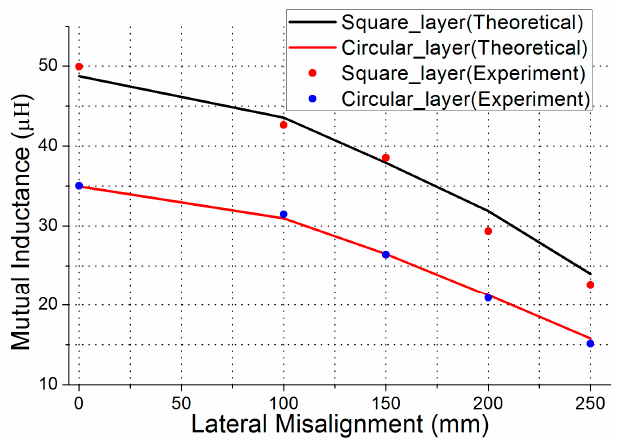
Figure 8. Mutual inductance of two coupling coils with ferrite layers only.